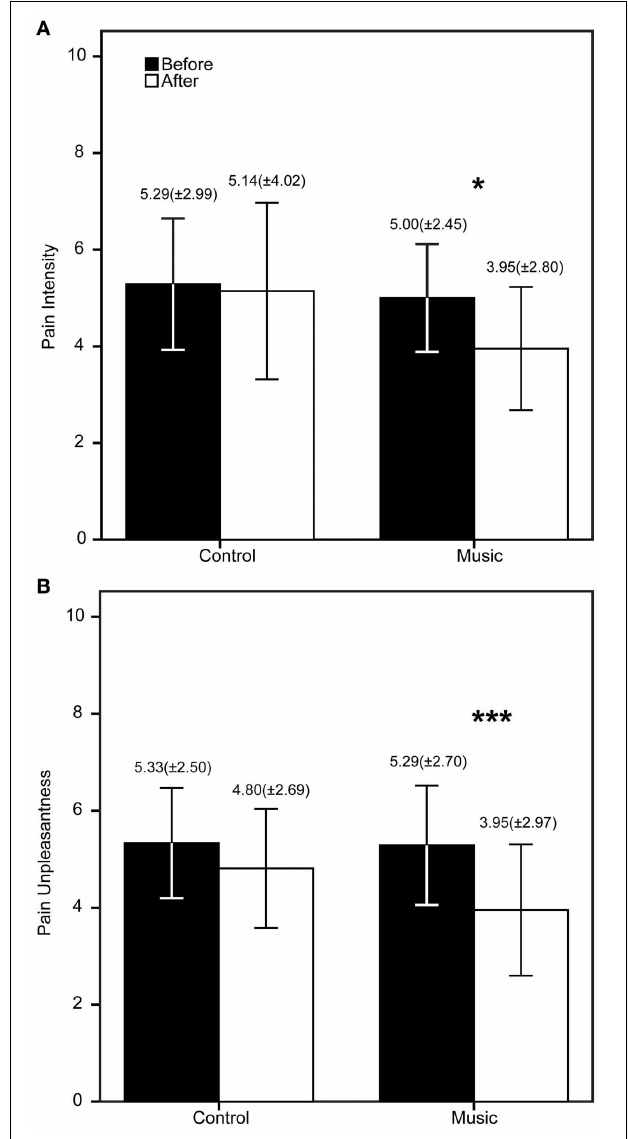
FIGURE 2 | Results of the verbal rating scale (VRS) before and after the control/music conditions. The bars represent the mean of each measure ( A = Pain intensity, B = Pain unpleasantness), whereas the error bars represent the standard deviation. Above the error bars we show the Mean ( SD ) for each measure. ∗ p < 0 . 05, ∗∗∗ p < 0 .